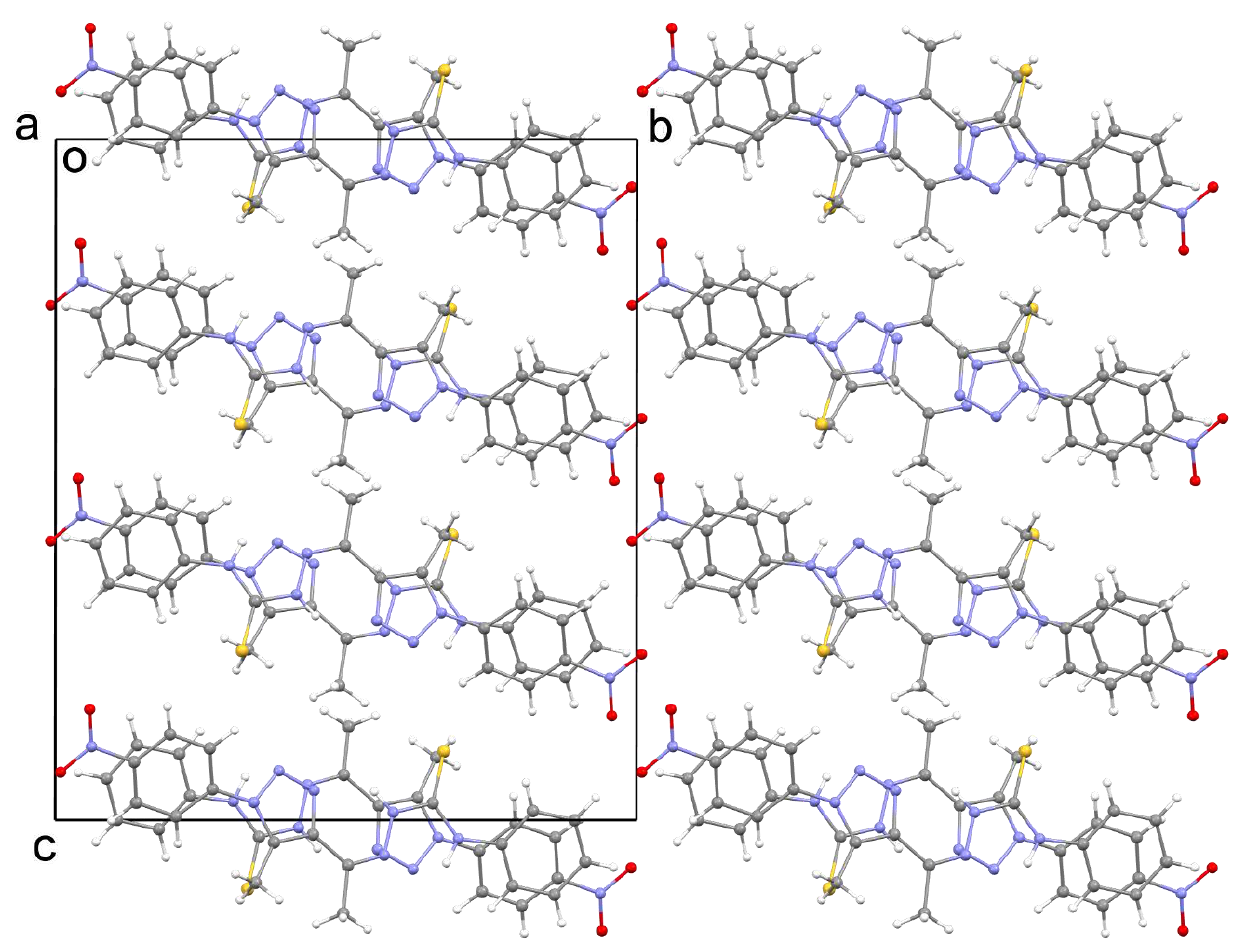
Figure 2. A view of the crystal structure of 3 down the a axis with the unit cell outline shown ( a – c ).